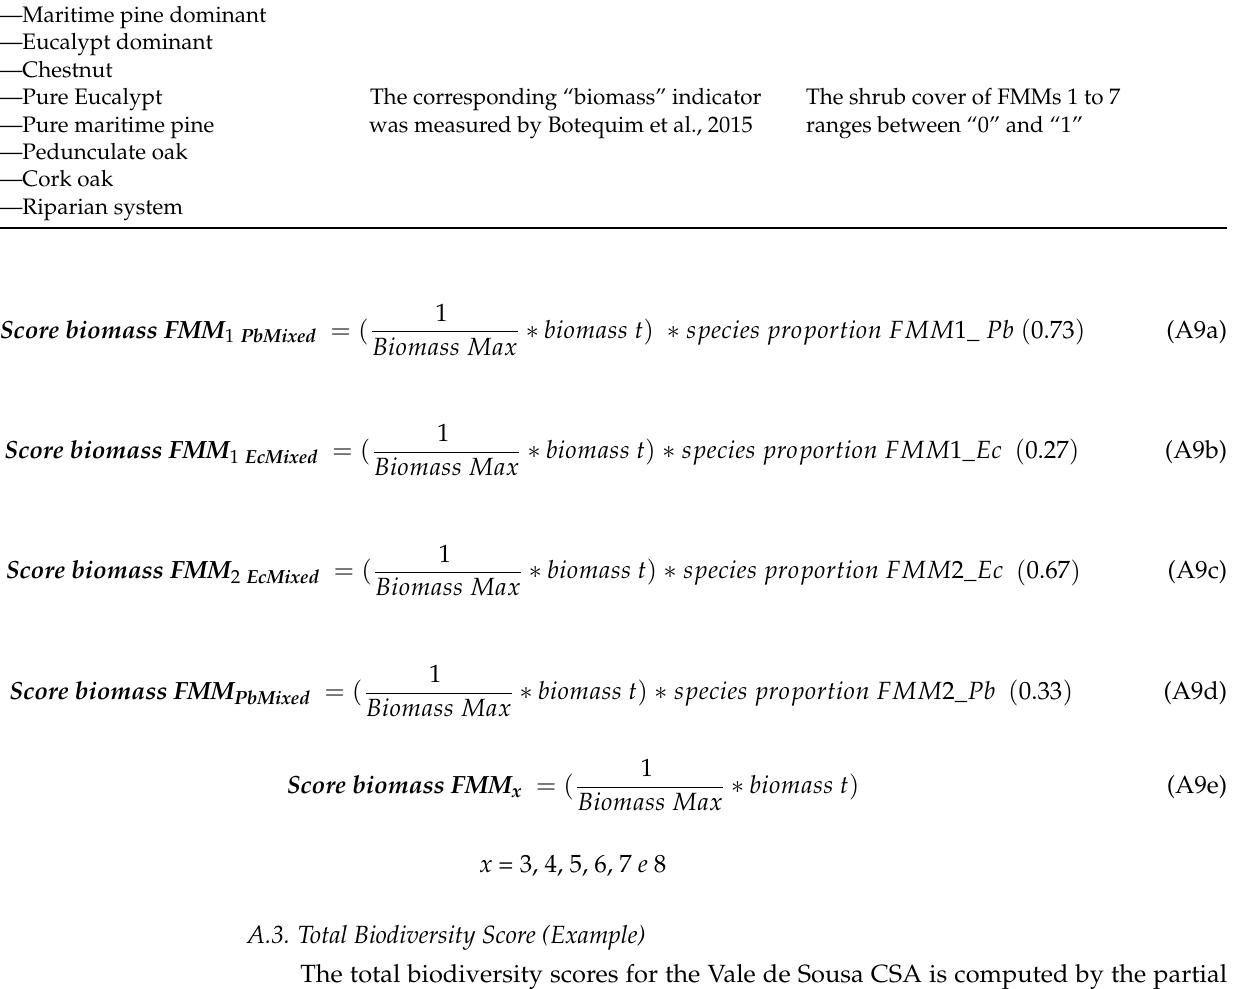
Table 9. Shrub cover, description, minimum and maximum values used to define the biomass biodiversity score. #2. Shrub